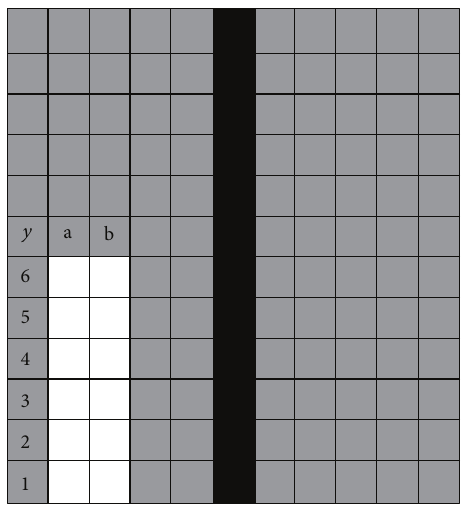
Figure 4: Template for basic function